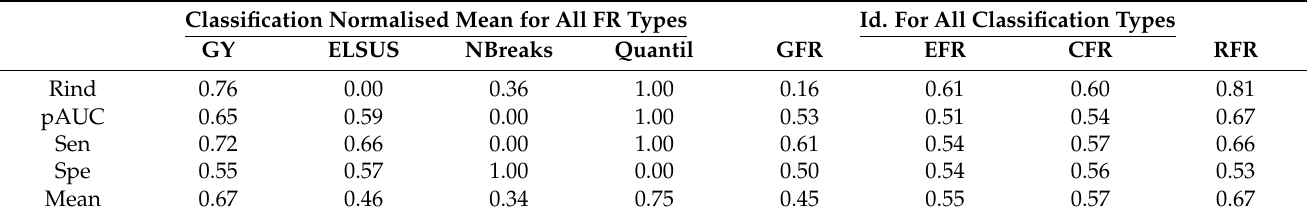
Table 11. Normalisation of mean values. The highest values are shaded. Classification Normalised Mean for All FR Types Id. For All Classification Types